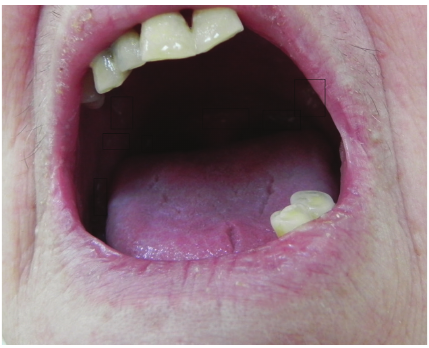
Figure 8: Oral lesions are detected as white papules with a central